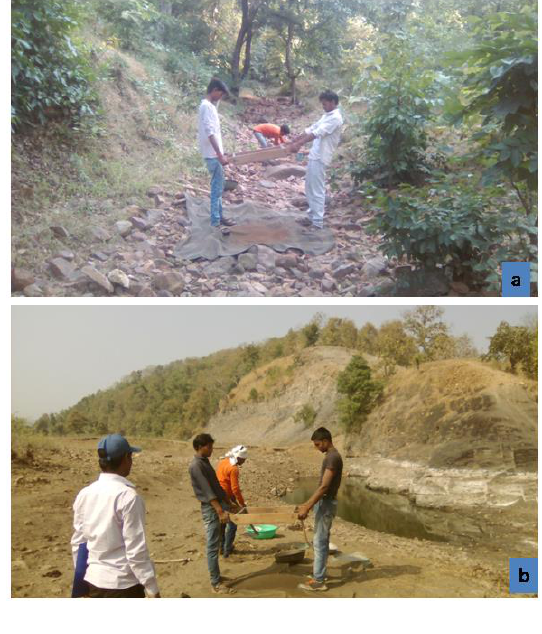
Figure 7: a. Samples collection at the stream occurring within the prospective zones. b. Sample preparation for identifying the indicator